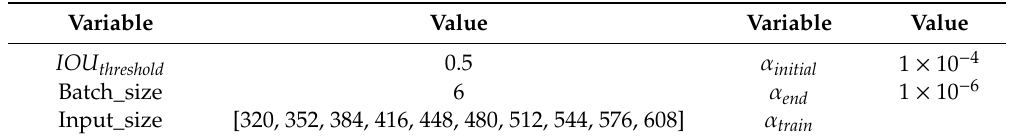
Table 3. The training parameters.